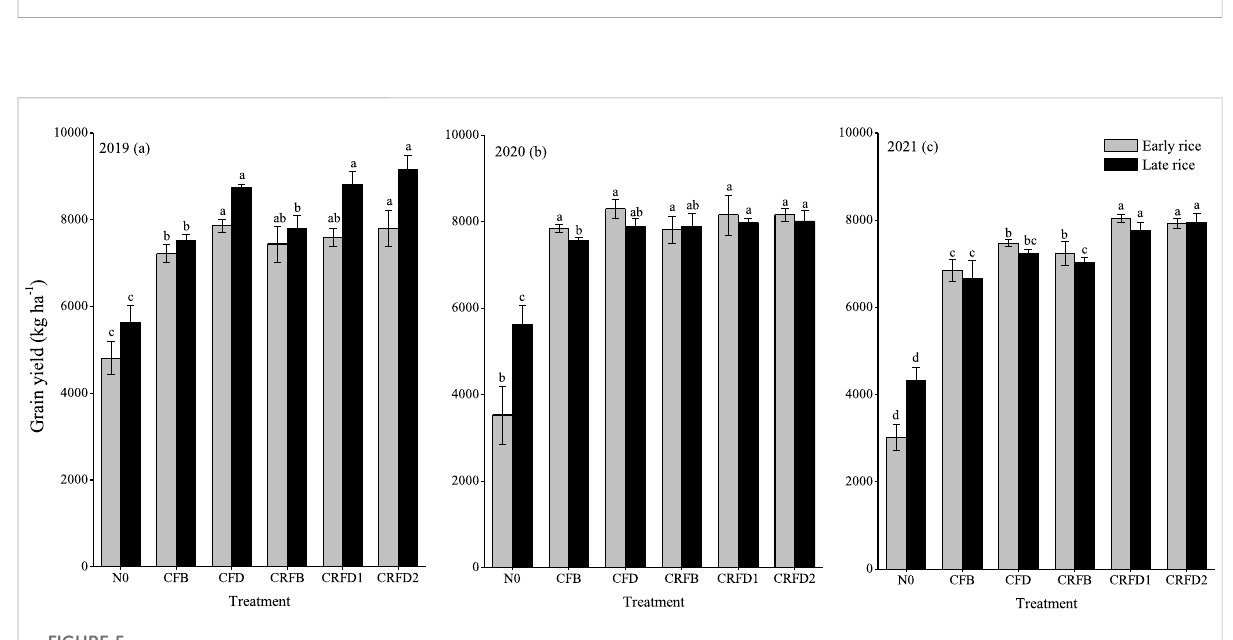
FIGURE 5 Thegrainyield forearly andlatericeunderdifferenttreatments in2019 (A) ,2020 (B) and2021 (C) . Valuesarepresentedas themean±standard deviation( n =3).Differentlowercaselettersabovethecolumnindicatesigni fi cantdifferenceat p < 0.05.N0:noNfertilizer;CFB:compoundfertilizer broadcasting; CFD: compound fertilizer side-deep placement; CRFB: controlled-release N fertilizer broadcasting; CRFD1: controlled-release N fertilizer side-deep placement; CRFD2: controlled-release N fertilizer side-deep placement, one-time